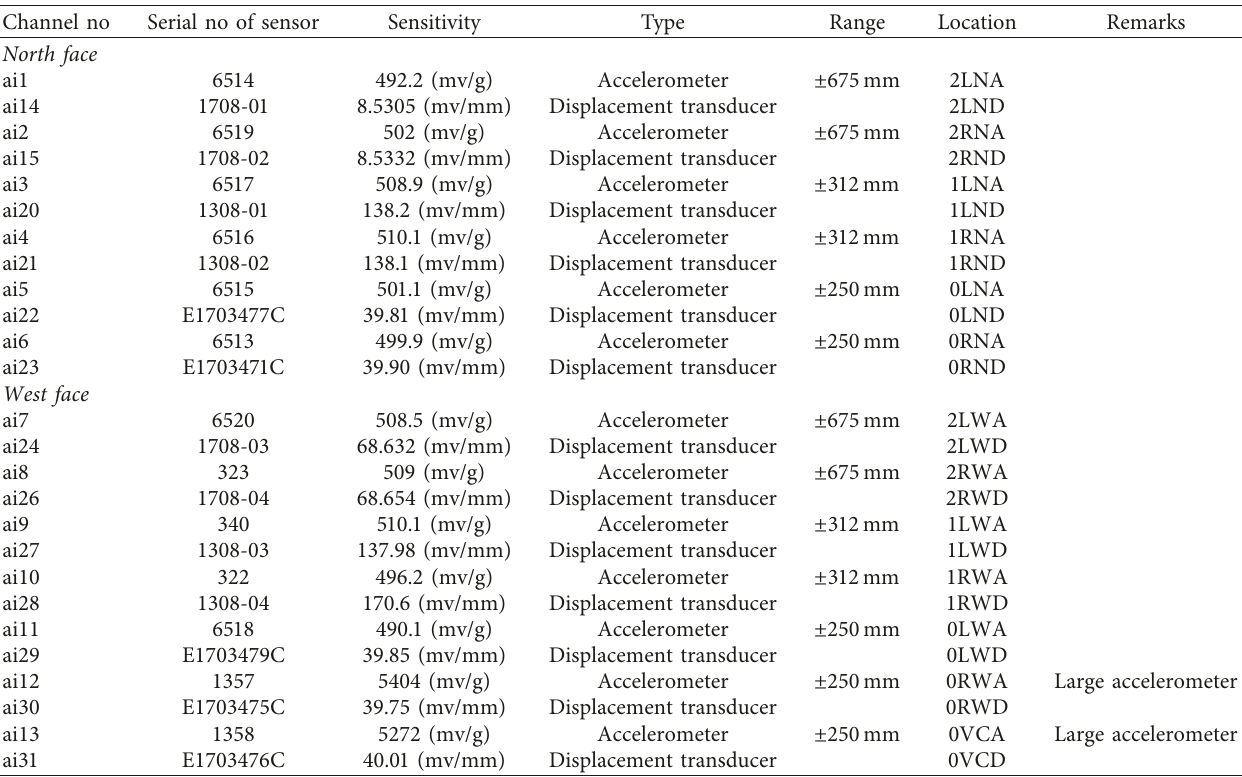
Table 5: Detail summary of